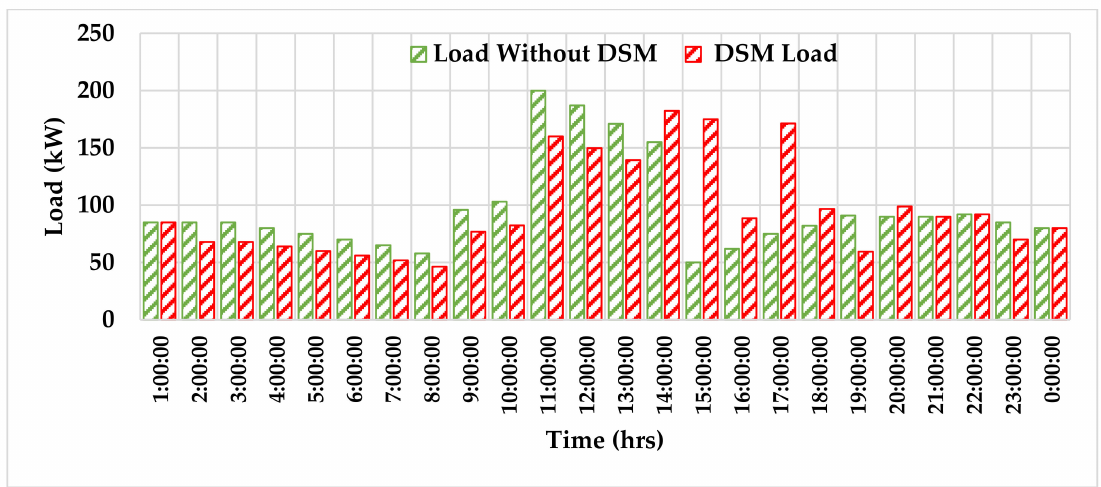
Figure 16. Daily load profile of AEO at 60%